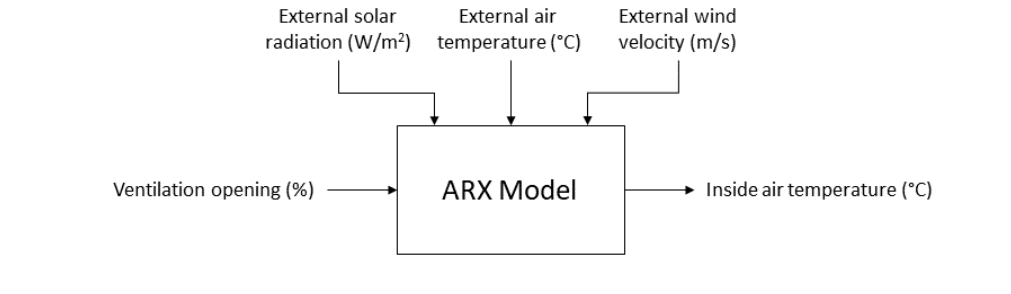
Figure 6. Representative diagram for the implemented ARX